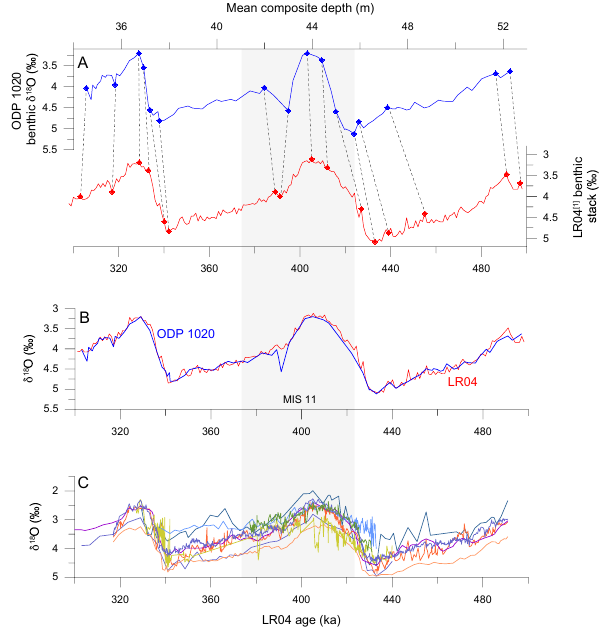
Fig. 2. Example for the age tuning of the benthic δ 18 O record of ODP Site 1020 to the benthic LR 04 stack (Lisiecki and Raymo, 2005): (A) selection of age control points in the δ 18 O of ODP Site 1020 and the LR04 stack, (B) comparison of the tuned δ 18 O record of ODP Site 1020 with the LR04 stack, and (C) nine benthic and planktonic oxygen isotope records from the North Atlantic used in this study tuned to the LR04 stack by the method as shown in pan- els (A) and (B) . The gray area indicates the MIS11 time interval according to Lisiecki and Raymo